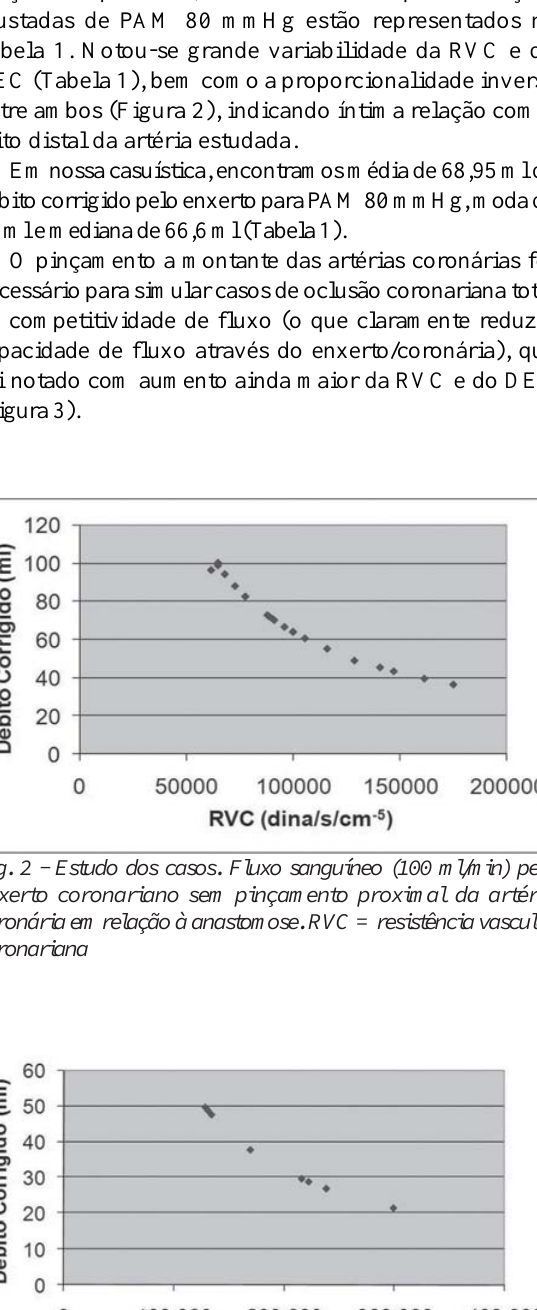
Fig. 3 - Estudo dos casos. Fluxo sanguíneo (50 ml/min) pelo enxerto coronariano com pinçamento proximal da artéria coronária em relação à anastomose. RVC = resistência vascular